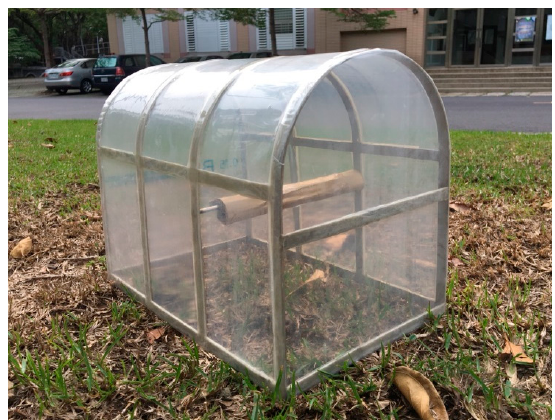
Figure 11. A simple simulated greenhouse.